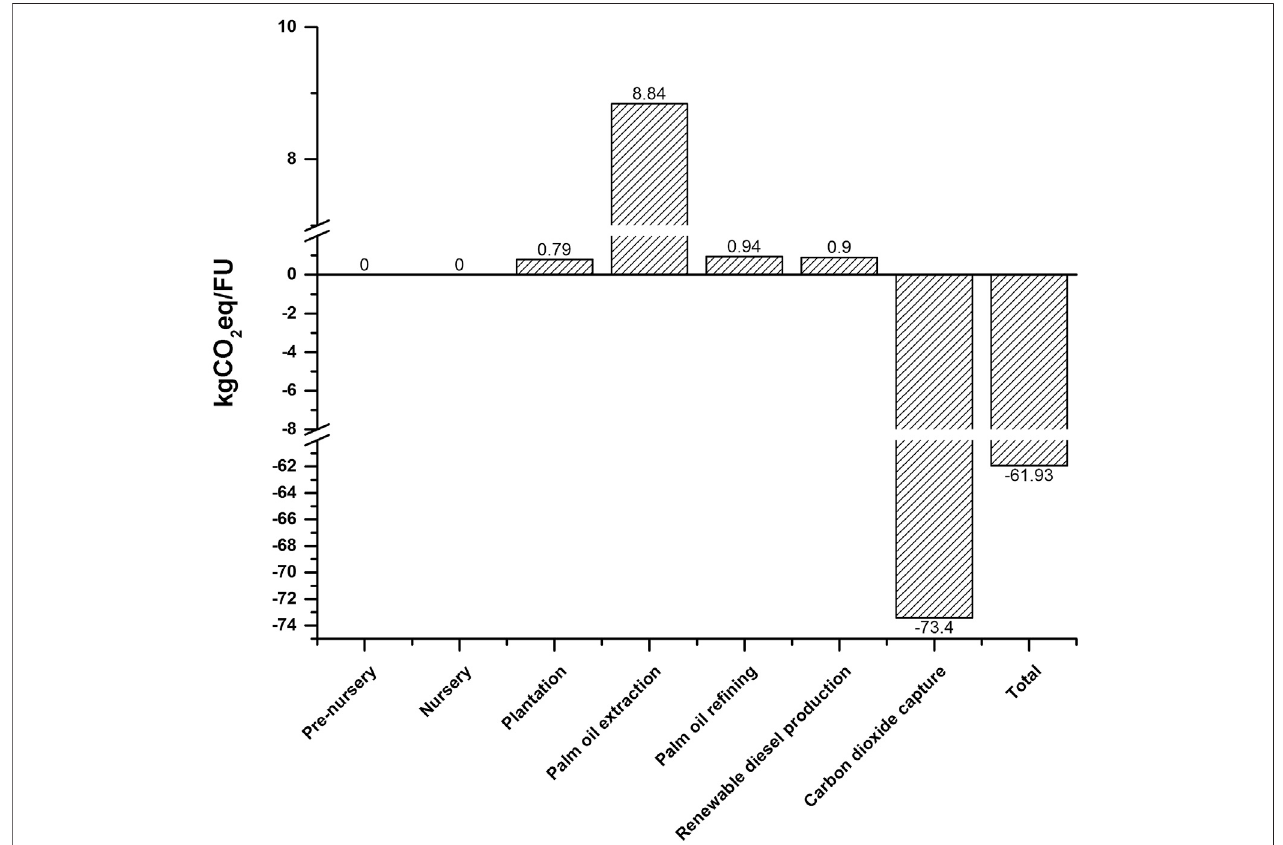
FIGURE 3 | Carbon footprint for the production